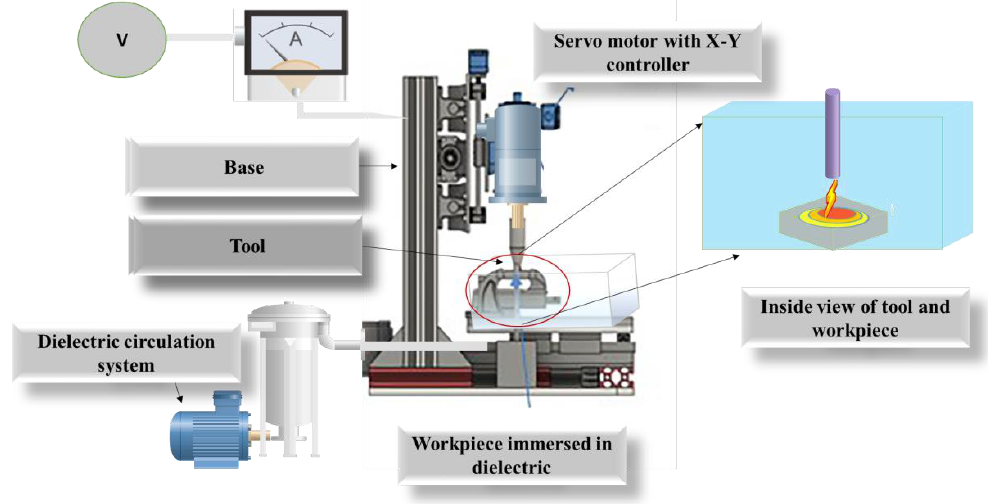
Figure 2. Schematic of EDM machine used for copper particle synthesis with filtration system setup.